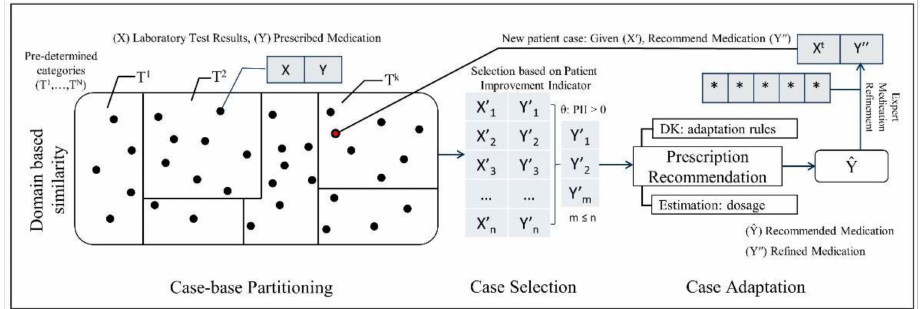
Figure 3. Schematic representation of the proposed hybrid knowledge modeling approach.